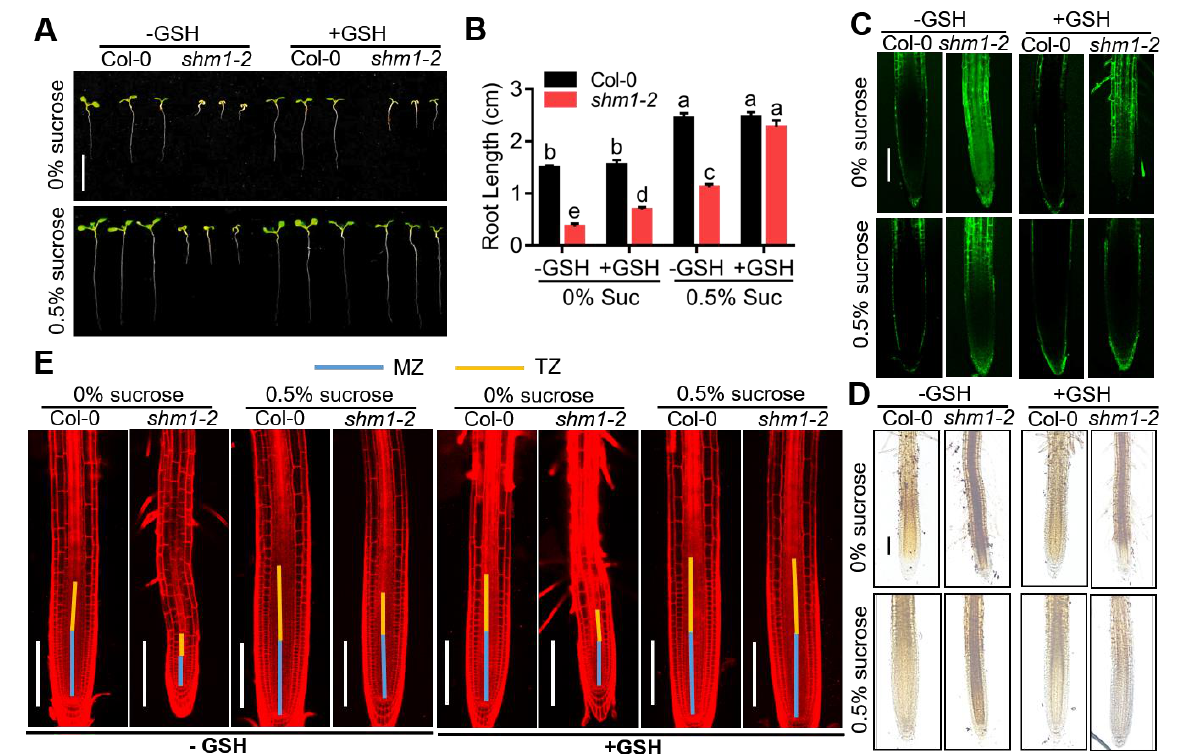
Figure 6. GSH treatment partially rescued the growth-arrest phenotype of the shm1-2 mutant at low-sucrose conditions. ( A ) The primary-root-growth phenotype of Col-0 and shm1-2 at low-sucrose conditions plus 200 μM GSH or not for 8 days. Bars = 1 cm. ( B ) Statistical analyses of the root length in ( A ). Different letters above error bars indicated significant difference at p < 0.05, using two-way ANOVA with Tukey’s test. ( C , D ) H 2 DCFDA ( C ) and DAB ( D ) staining for H 2 O 2 in primary roots of 8-day-old Col-0 and shm1-2 seedlings at low-sucrose conditions plus 200 μM GSH or not. Bars = 200 μm. ( E ) The root-meristem and transition-zone size of Col-0 and shm1-2 at low-sucrose conditions plus 200 μM GSH or not for 8 days. Bars = 200 μm.